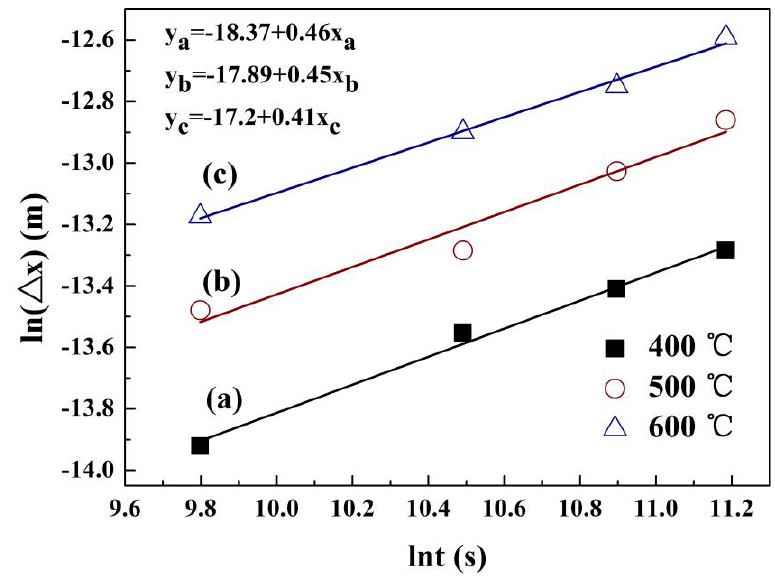
Figure 5. Relationship between the diffusion thickness of Al atoms and time at different temperatures.